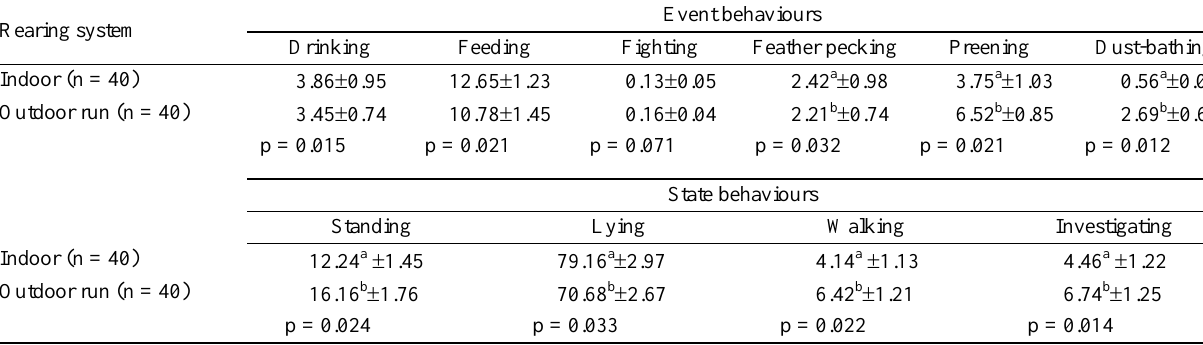
Table 2. Effect of rearing system on behavioral activities 1, 2,